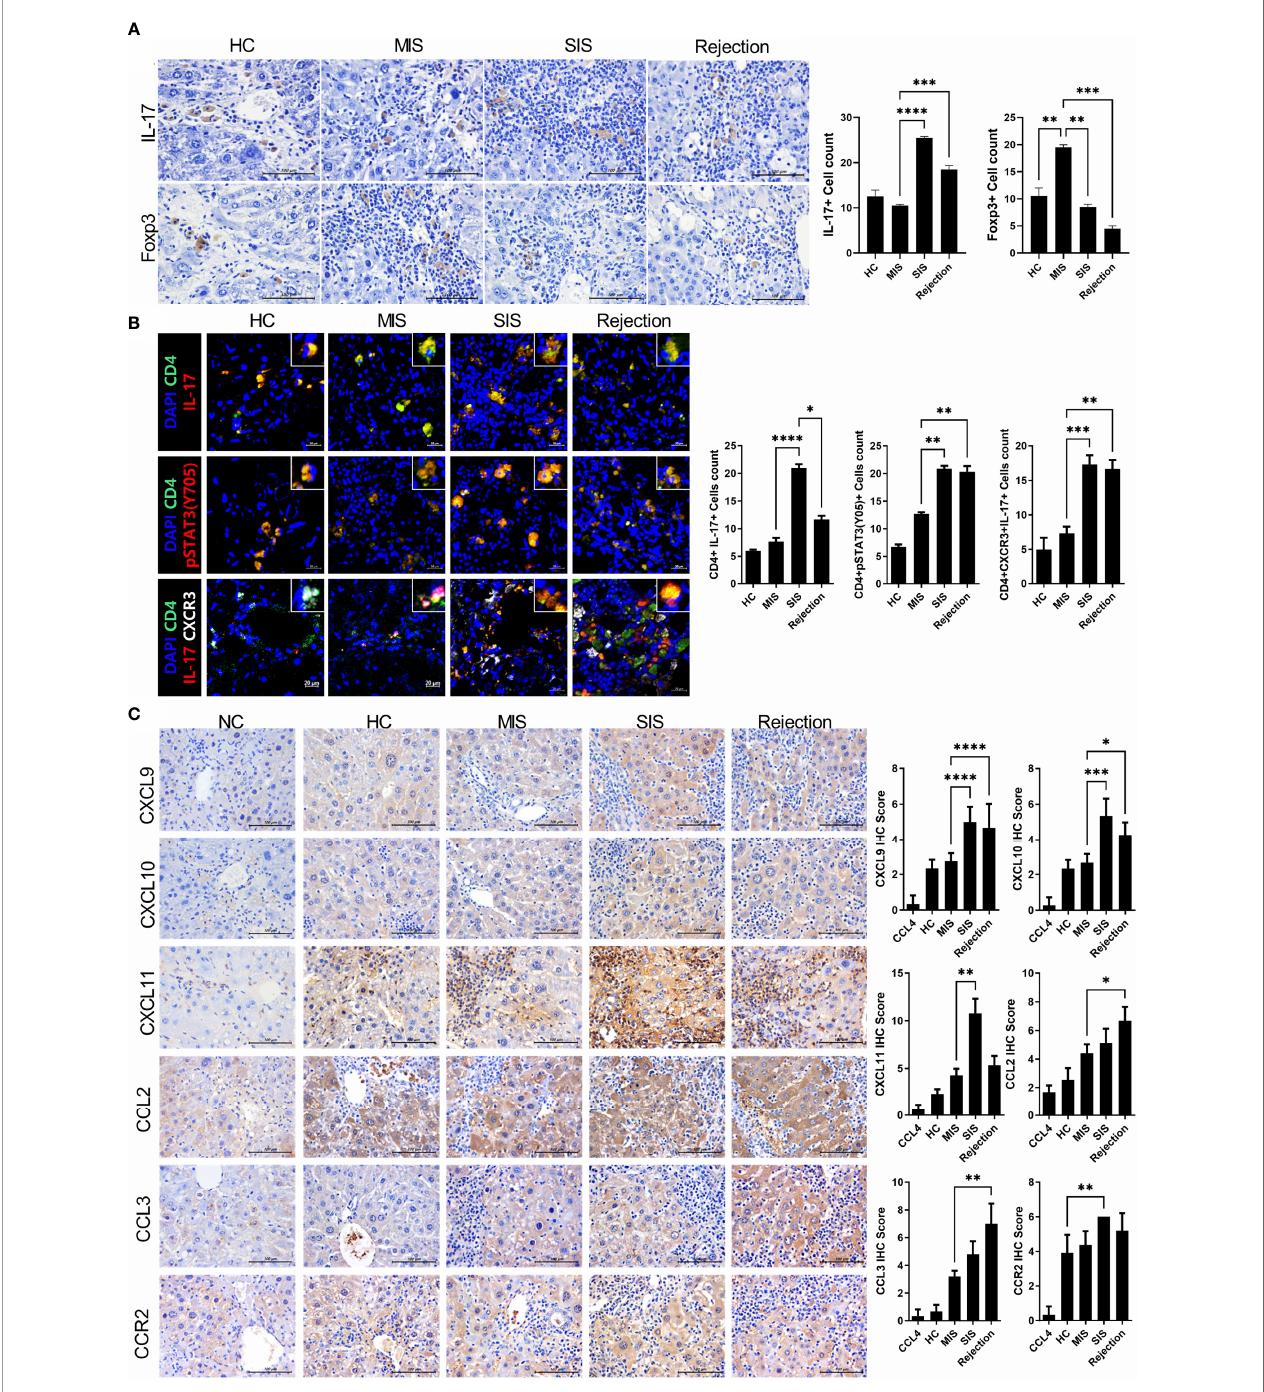
FIGURE 4 | Comparative analysis of in fi ltrated T-cell subtypes and chemotaxis in the liver of each avatar model group. (A) Representative images of IHC with anti- IL-17, FoxP3 antibodies. Bars are percentages of positive areas per fi eld. (B) Representative confocal microscopy analysis of Th17 cell localization in liver tissues. Cells were stained with fl uorescence-tagged antibodies to determine the counts of CD4 + IL-17 + , CD4 + pSTAT3(tyr 705) + , and CD4 + IL-17 + CXCR3 + cells in liver tissue sections (×100, original magni fi cation). (C) Representative images of IHC with anti-CXCL9, CXCL10, CXCL11, CCL2, CCL3, and CCR2 antibodies. Bars indicate the percentages of positive areas per fi eld. Data are the means±SEM of two replicates. * P < 0.05, ** P < 0.01, *** P < 0.001, **** P < 0.0001. IHC, immunohistochemistry; MIS, mild in fl ammation in stable; SIS, severe in fl ammation in stable; NC, negative control; HC, healthy